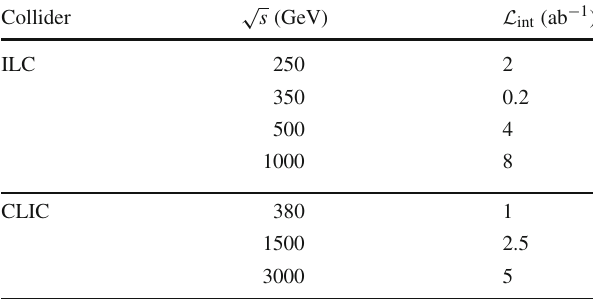
Table 1 Expected center of mass energies and integrated luminosities in the different stages of both the ILC and CLIC